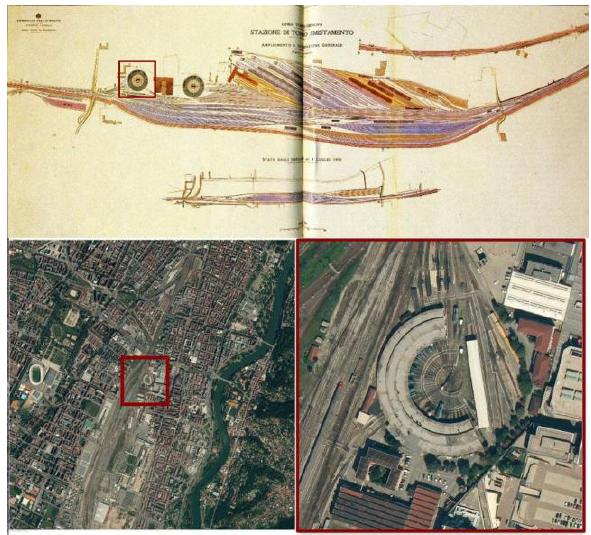
Figure 2. On the top, masterplan of the new intervention compared to the existing situation in 1905 (Ballatore,